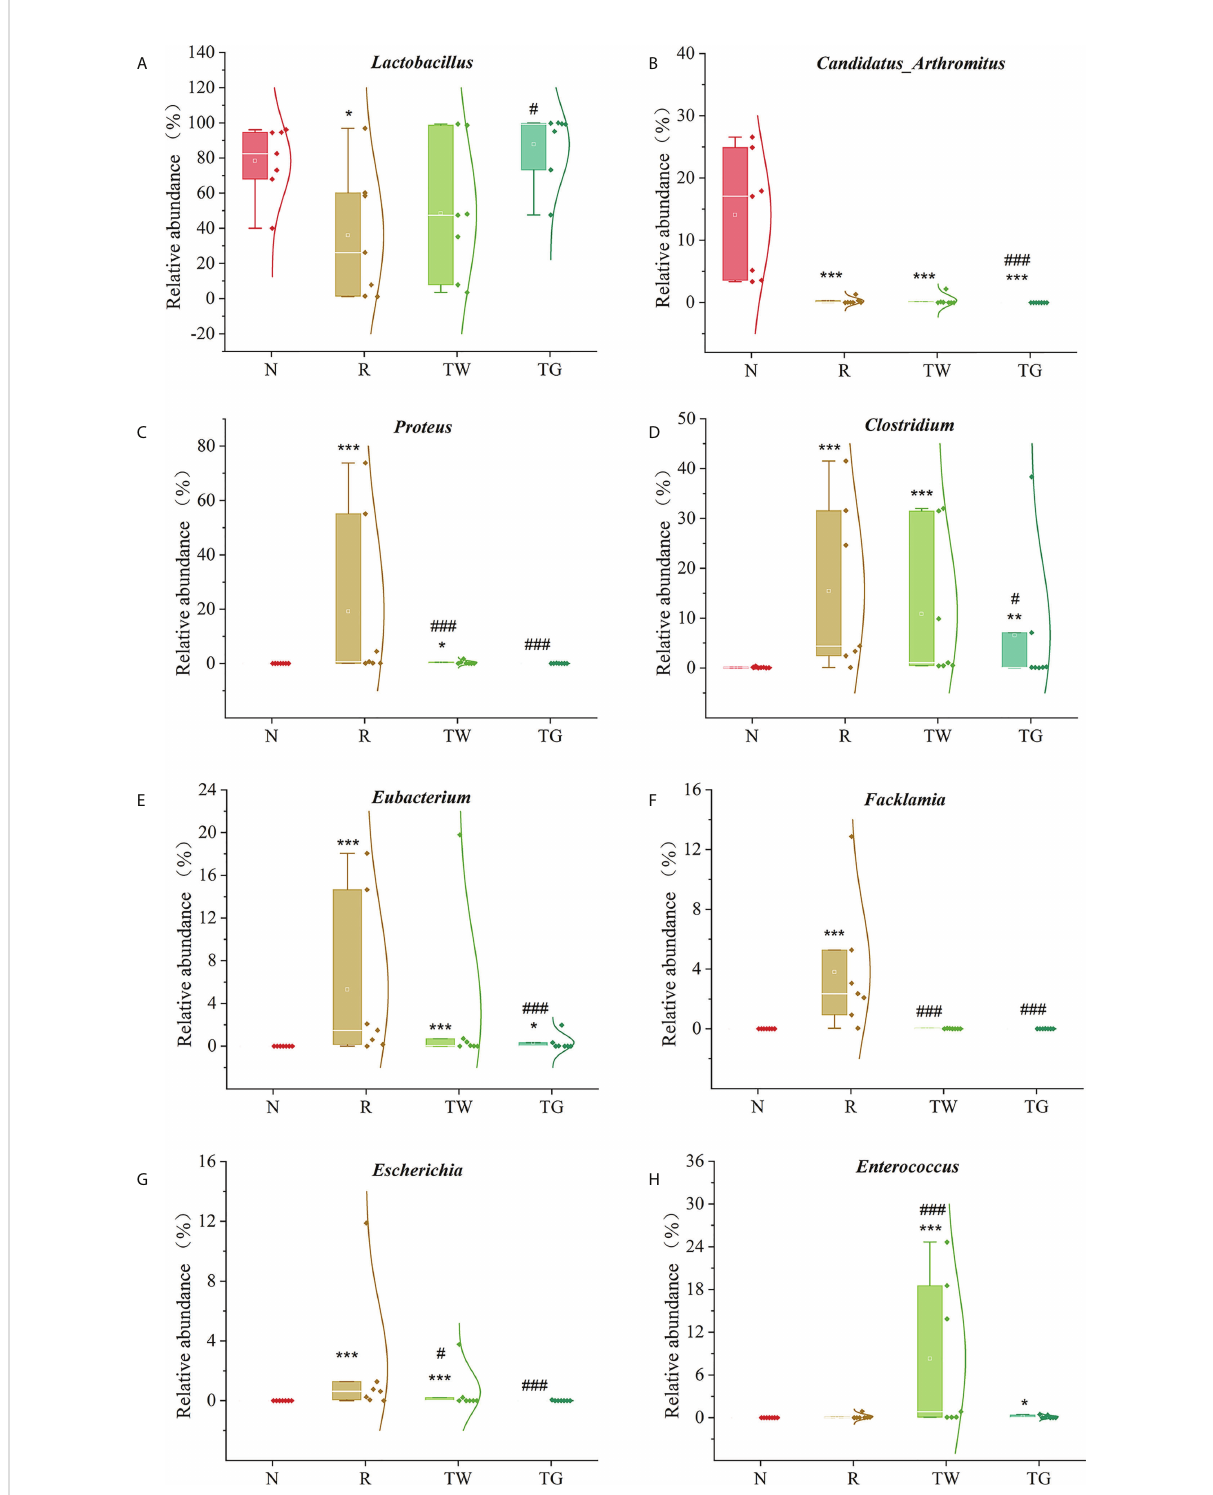
FIGURE 3 Relative abundance of signature genera. N, normal control group; R, antibiotic-associated diarrhea (AAD) restore group; TW, Qiwei Baizhu Powder (QWBZP) decoction group; TG, total glycosides of Qiwei Baizhu Powder (QWBZP-TG) group. Data are expressed as mean ± standard deviation (SD), n = 7. * P < 0.05, ** P < 0.01, and *** P < 0.001 compared with the N group; # P < 0.05 and ### P < 0.001 compared with the R